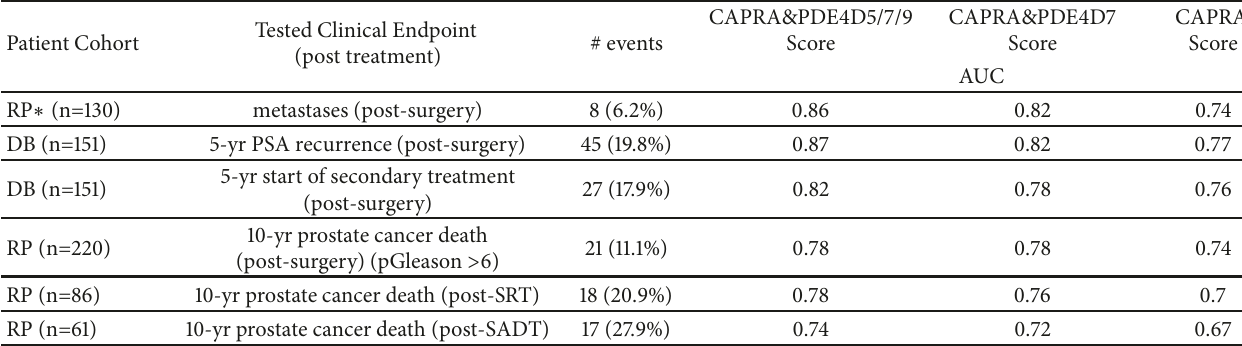
Table 2: Overview of the AUCs for the CAPRA score, the CAPRA and PDE4D7, and the CAPRA and PDE4D5/7/9 regression models to predict multiple endpoints in various patient cohorts. The patient cohort that was used for the respective endpoint is indicated including the number of patients with respective follow-up periods. The tested clinical endpoints are given including the number and percentage of the respectively tested events. Note. The CAPRA score is calculated based on [23]; however, as the information on the number of positive biopsy cores was missing for the RP ∗ cohort the CAPRA score for this cohort was calculated using patient age, pre-operative PSA, biopsy Gleason score, and clinical stage only. The influence of the missing information on the biopsy cores was very limited as tested on the RP as well as the DB cohort (data not